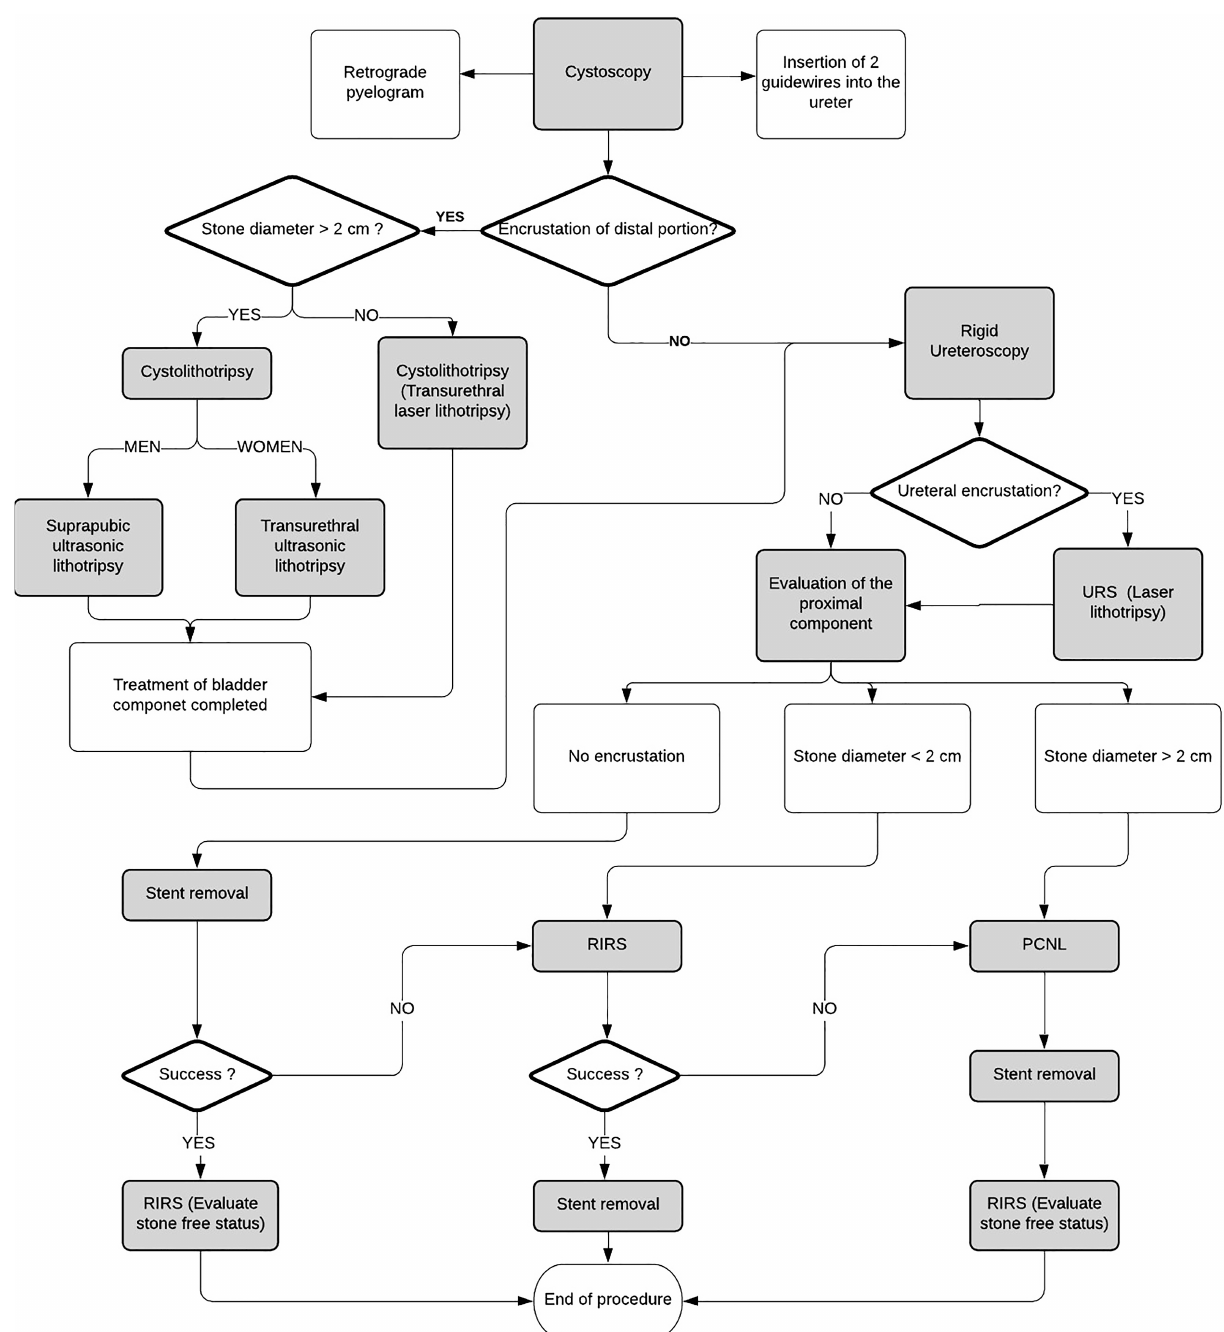
Figure 2 - Surgical technique: Flow chart